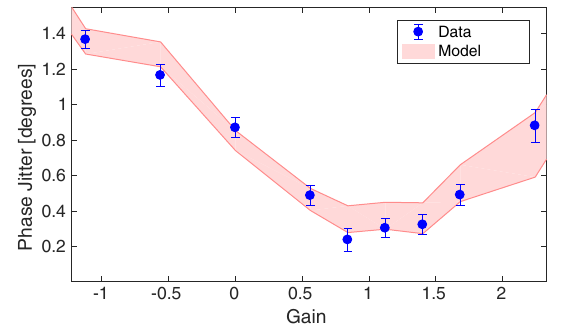
FIG. 4. Measured corrected beam phase jitter at M 3 vs PFF gain (points). Error bars show the statistical standard error on the measured jitter values. The expected performance is shown by the red shaded region (see